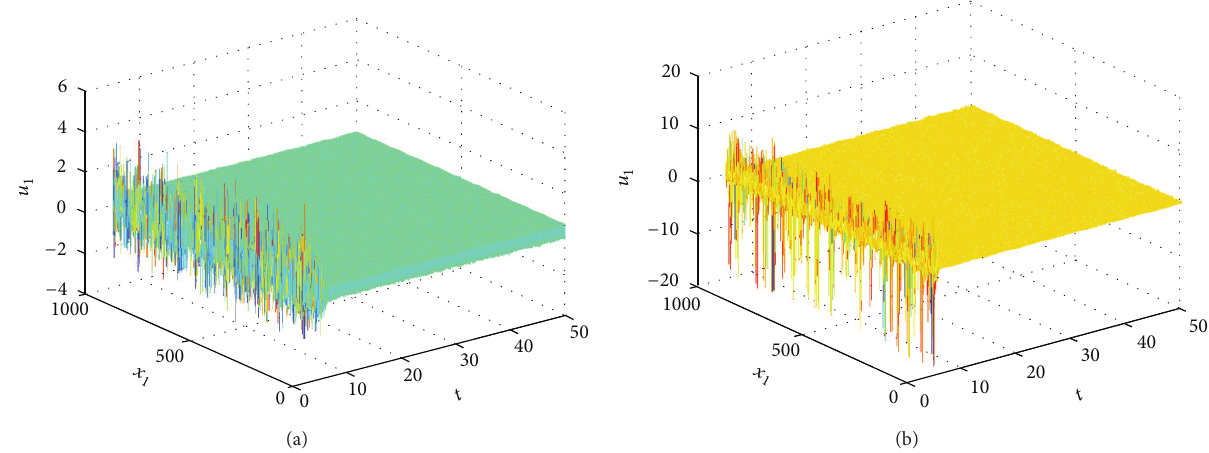
Figure 1: Transient behaviors of the state variables 𝑢 1 (𝑡,𝑥) and 𝑢 2 (𝑡,𝑥) in the